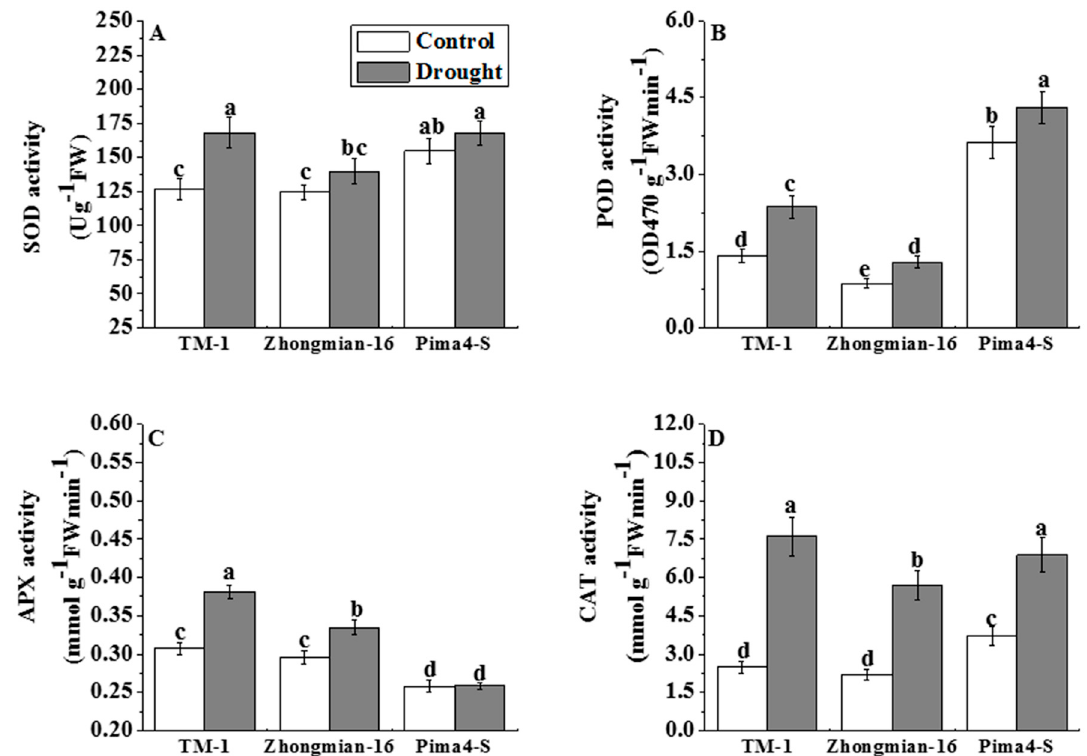
Figure 5. Effects of drought on superoxide dismutase (SOD, A ); peroxidase (POD, B ); ascorbate peroxidase (APX, C ) and catalase (CAT, D ) activities in leaves of three cotton species. Means denoted by the same letter are not significantly different at p < 0.05. Error bars are ± SD ( n = 4).